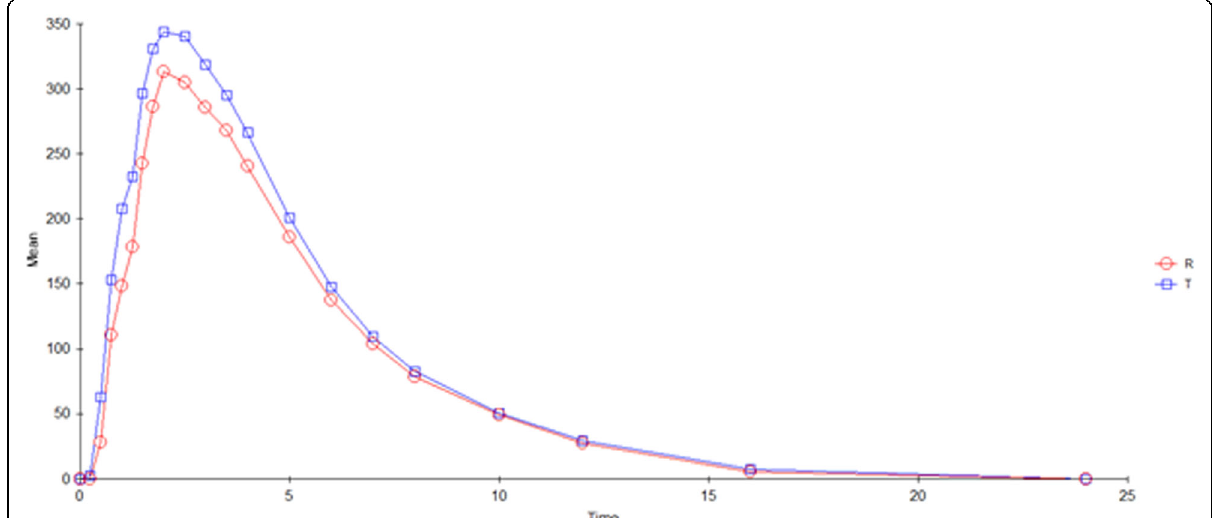
Fig. 5 Mean plasma concentration (ng/mL) profile of lenalidomide following 25 mg oral dose of test (T) and reference (R) preparation to 12 healthy human volunteers